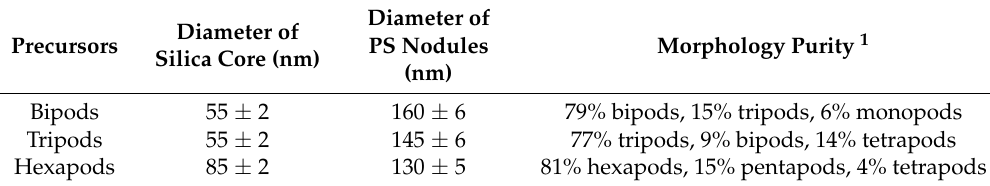
Table 1. Characteristics of the multipod-like